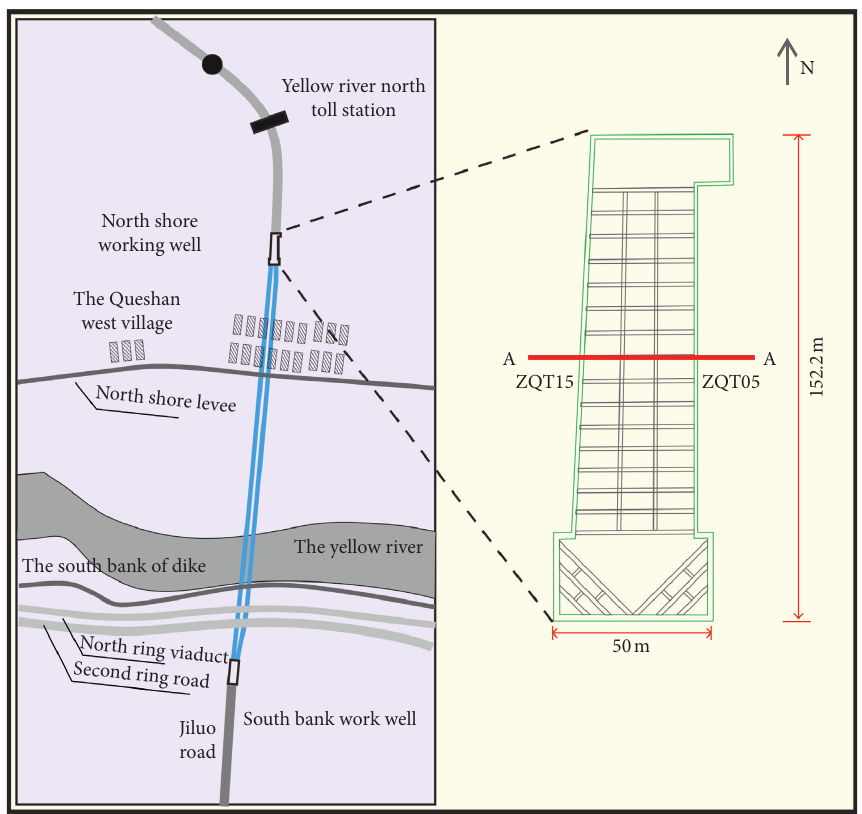
Figure 1: General situation of the starting shaft of a tunnel in Jinan.